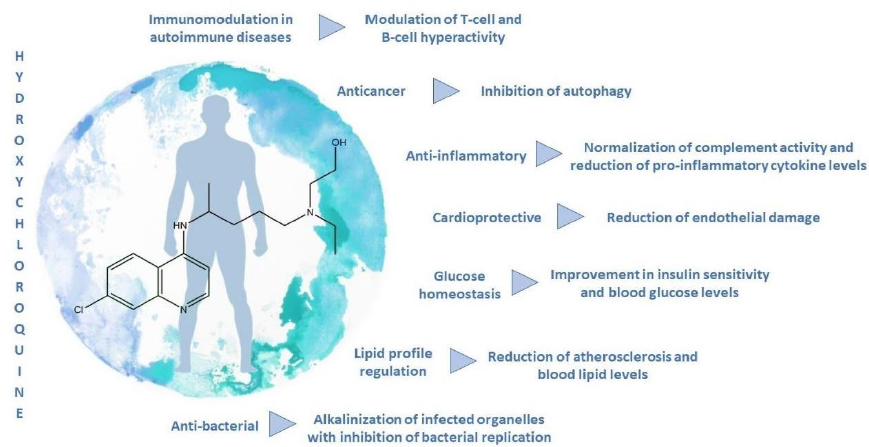
Figure 6. Major biological activities of Hydroxychloroquine (HCQ) and its relative mechanisms of action.